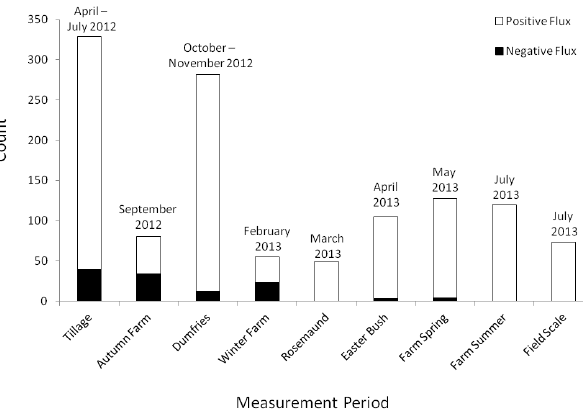
Figure 5. The number of negative and positive fluxes measured from all InveN 2 Ory field sites using the dynamic chamber method in chronological order (see Table 1 for